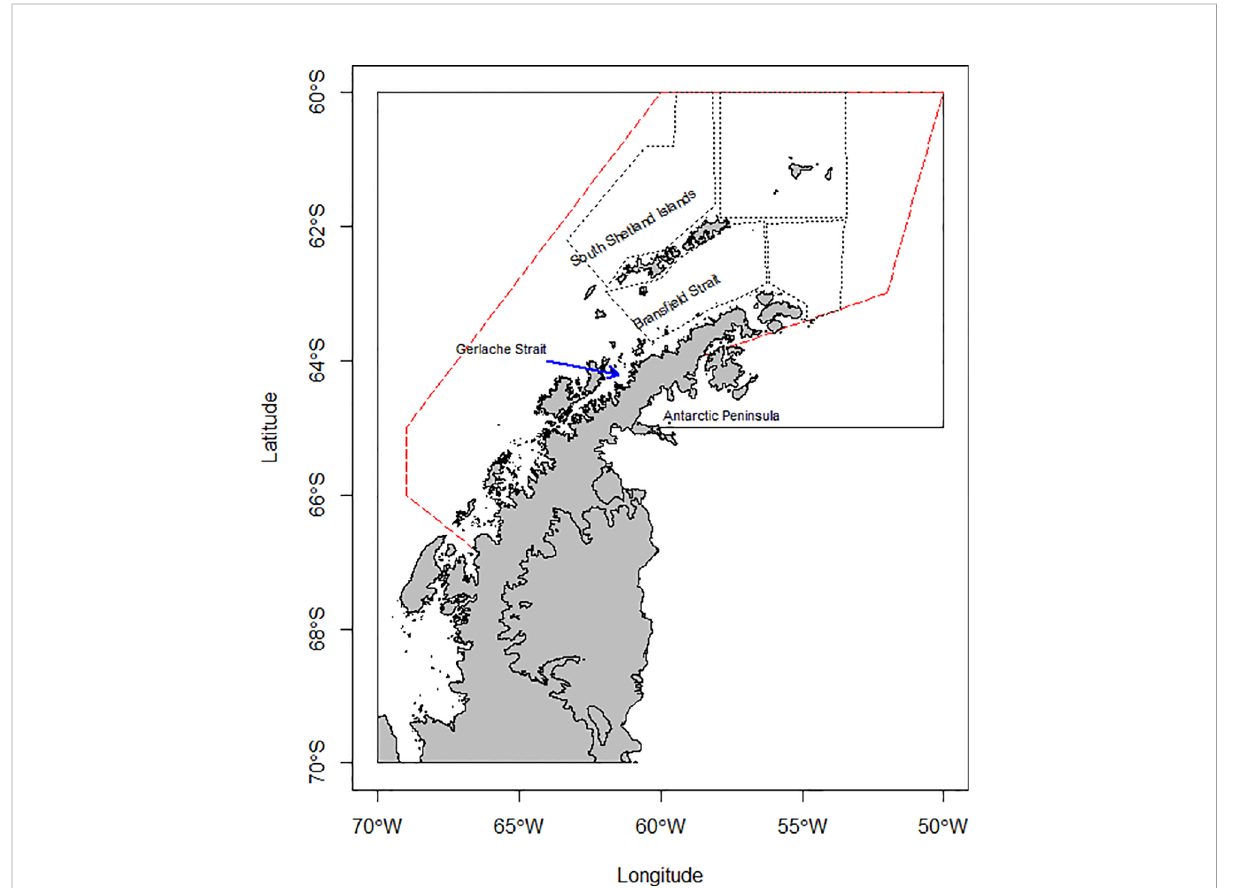
FIGURE 1 CCAMLR Subarea 48.1 (continuous line) with the operational footprint of the krill fi shery from 1979/80 to 2017/18 (red dashed line; from Trathan et al., 2018) and the strata surveyed for krill by U.S. Antarctic Marine Living Resources program (black dotted line, Reiss et al.,